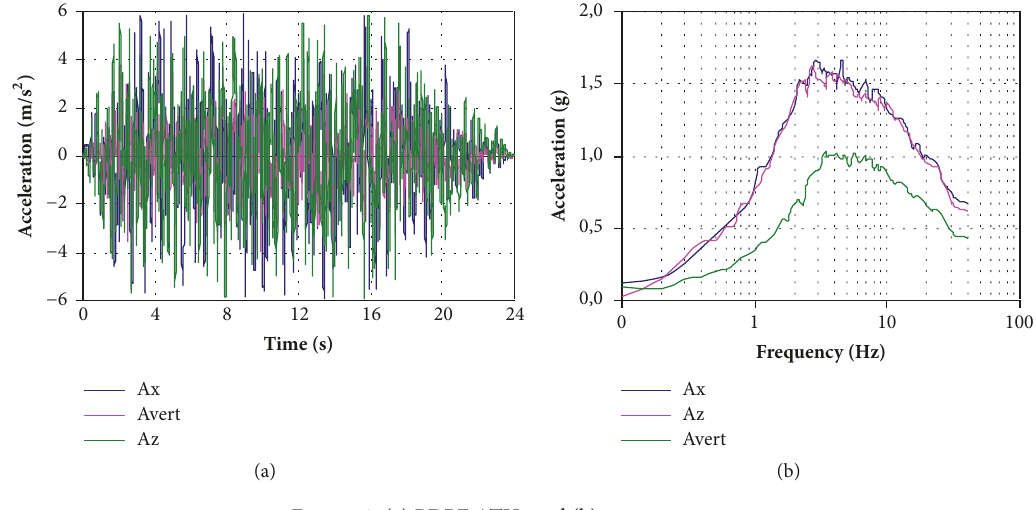
Figure 8: (a) BDBE ATHs and (b) response spectra. Table 1: Dynamic properties of SI-H 500/50